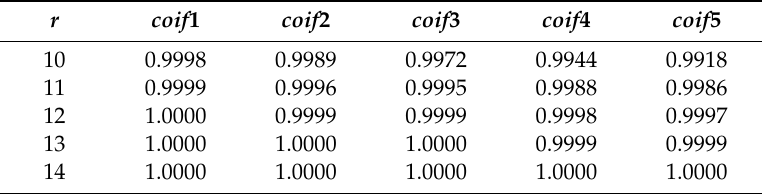
Table 28. Experimental results ( SSIM ) of 3D tomographic 12-bit image “Trufi_COR” DWT by using bit-width r of coiflets filters coe ffi